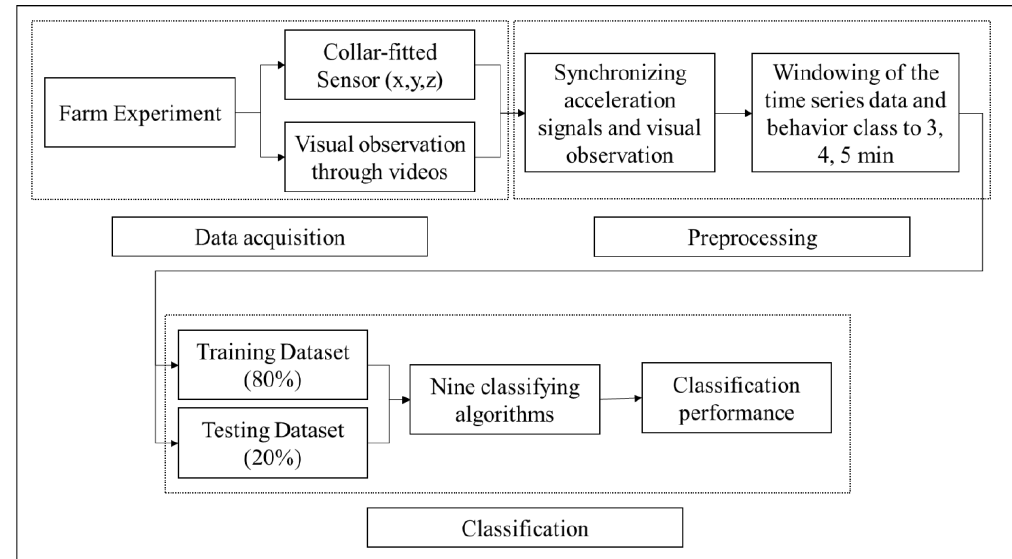
Figure 1. The process of evaluating the collar-fitted accelerometer sensor begins from the experiment in the field until the analysis of data and determination of the performance score of the classification algorithms used to identify behaviors of the cattle.